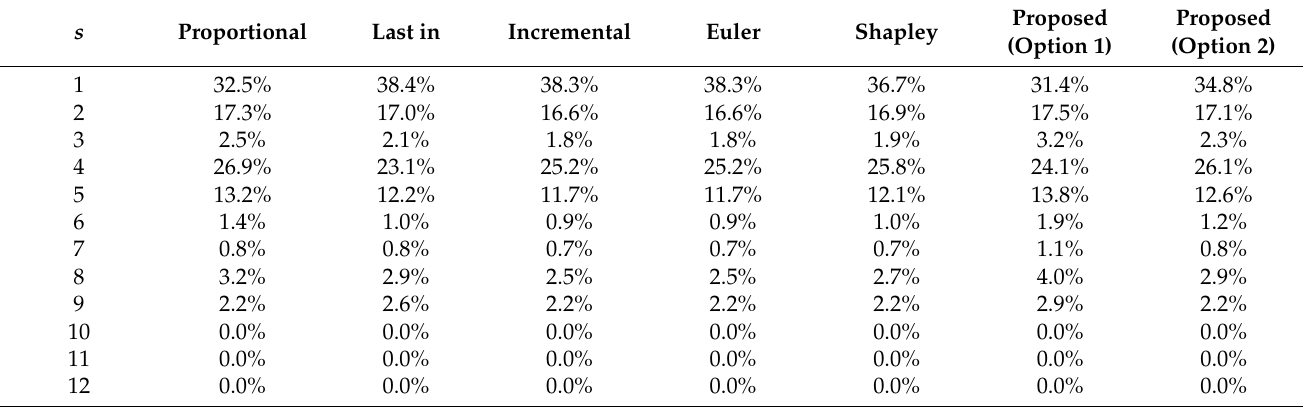
Table 6. Capital allocated (percentage with respect to the total) under different